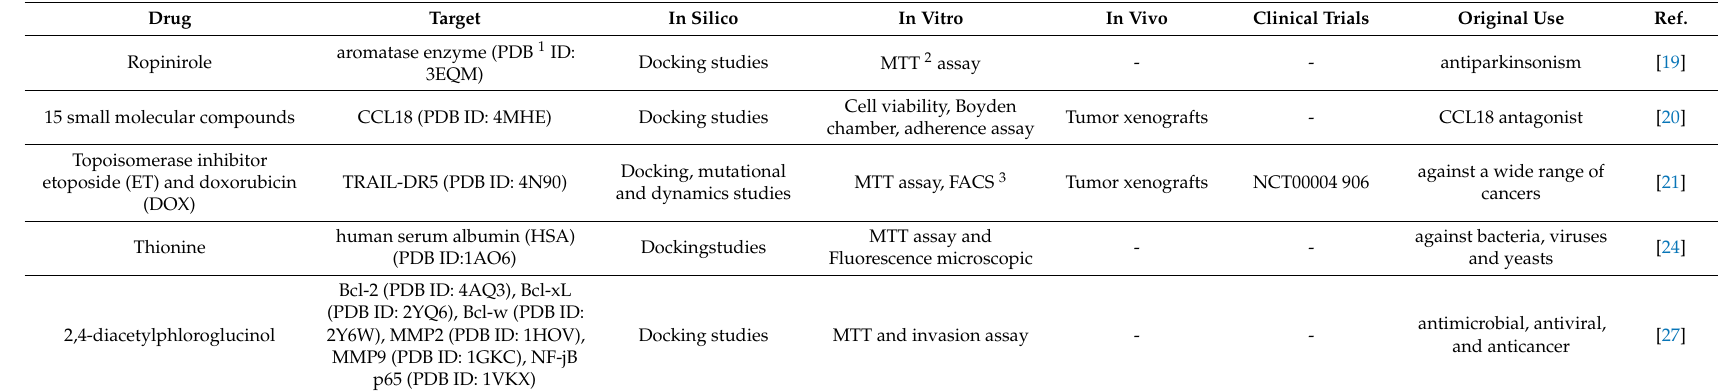
Table 1. Characteristics of the studies reported herein categorized as "systematic repositioning of drugs" used in metastatic breast cancer. The table reports the drug, its target with Protein Data Bank (PDB) ID, the in silico / in vitro / in vivo methods used to test the drug, clinical trials, the original use, and the